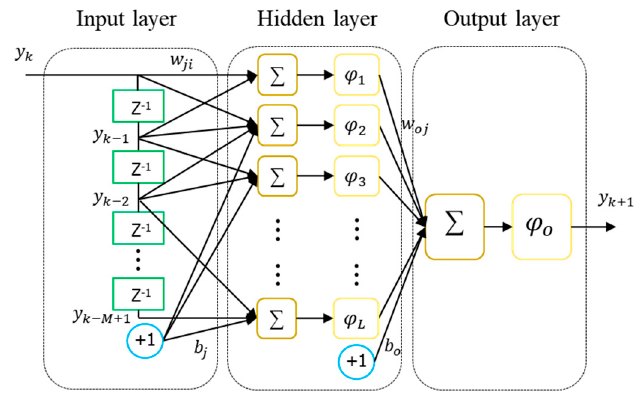
Figure 1. Architecture of the time-delayed neural network (TDNN).